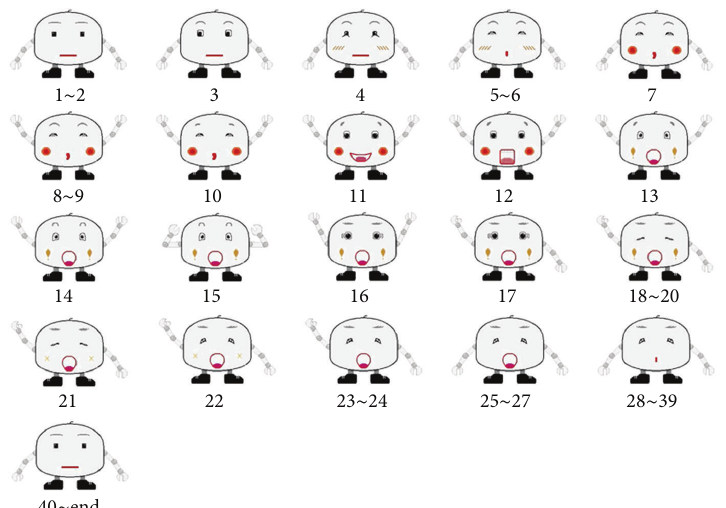
Figure 9: The emotional expressions based on emotions generated by young females.